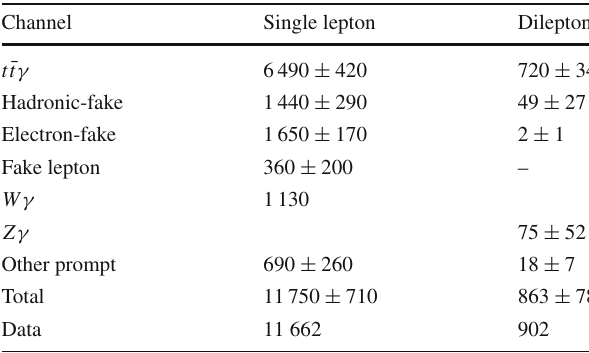
Table 2 The observed data and the expected event yields for the signal and backgrounds in the single-lepton and dilepton channels. All data- drivencorrectionsandsystematicuncertaintiesareincluded.Thesignals are scaled by the NLO k -factors. The fake-lepton background in the dilepton channel is negligible, represented by a “-”. The Z γ ( W γ ) backgroundinthesingle-lepton(dilepton)channelisincludedin“Other prompt”. The uncertainty of the W γ background in the single-lepton channel is not given since the normalization of this background is a free parameter in the likelihood